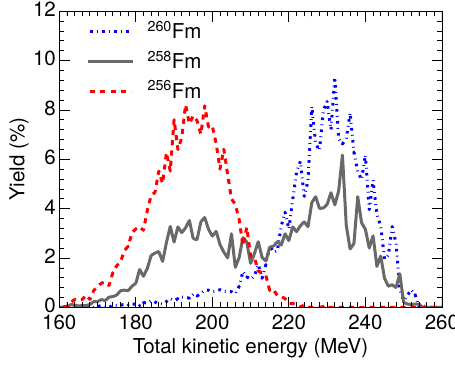
Figure 2. Typical scission shapes for 256 , 258 , 260 Fm obtained in the calculations.